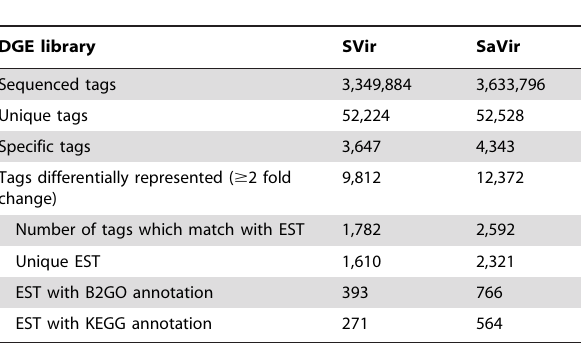
Table 1. General characteristics of DGE libraries generated from oysters surviving virulent (SVir) and avirulent (SaVir) Vibrio